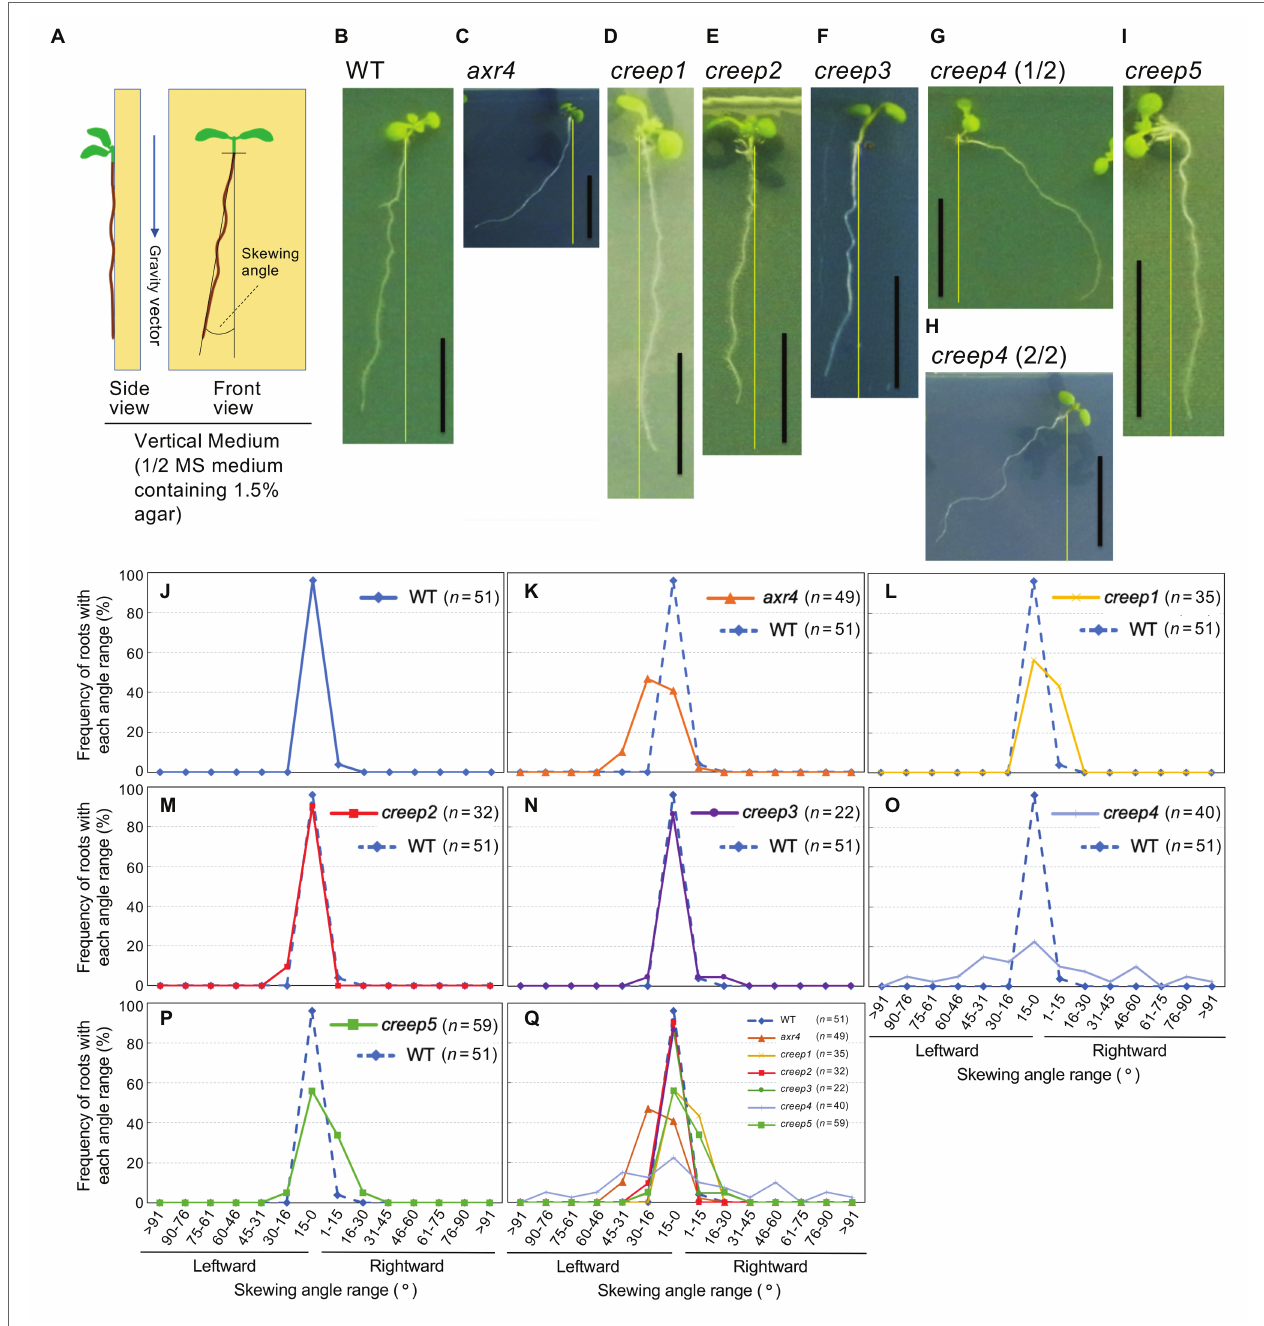
FIGURE 6 | Root skewing phenotypes of creep mutants. (A) Illustration of vertical medium (left panel) and representation of how to measure the skewing angle (right panel). Skewing was quantified by measuring the angle between the vertical axis and root tip. (B–I) Photographs of the root skewing of creep mutants as well as the controls, wild type, and axr4 mutants. The experiment was performed as described in the Materials and Methods section. Scale bar = 1 cm. (J–P) Quantification of the skewing angles of the creep mutants. According to the definition of the skewing angle shown in the right panel of (A) , the skewing angles of the creep mutants and the controls were measured, and the data of each creep mutant were individually compared to those of the wild type. Data of the wild type are shown with a dotted line in (K–P) for comparison. (Q) All the data in (J–P) are plotted